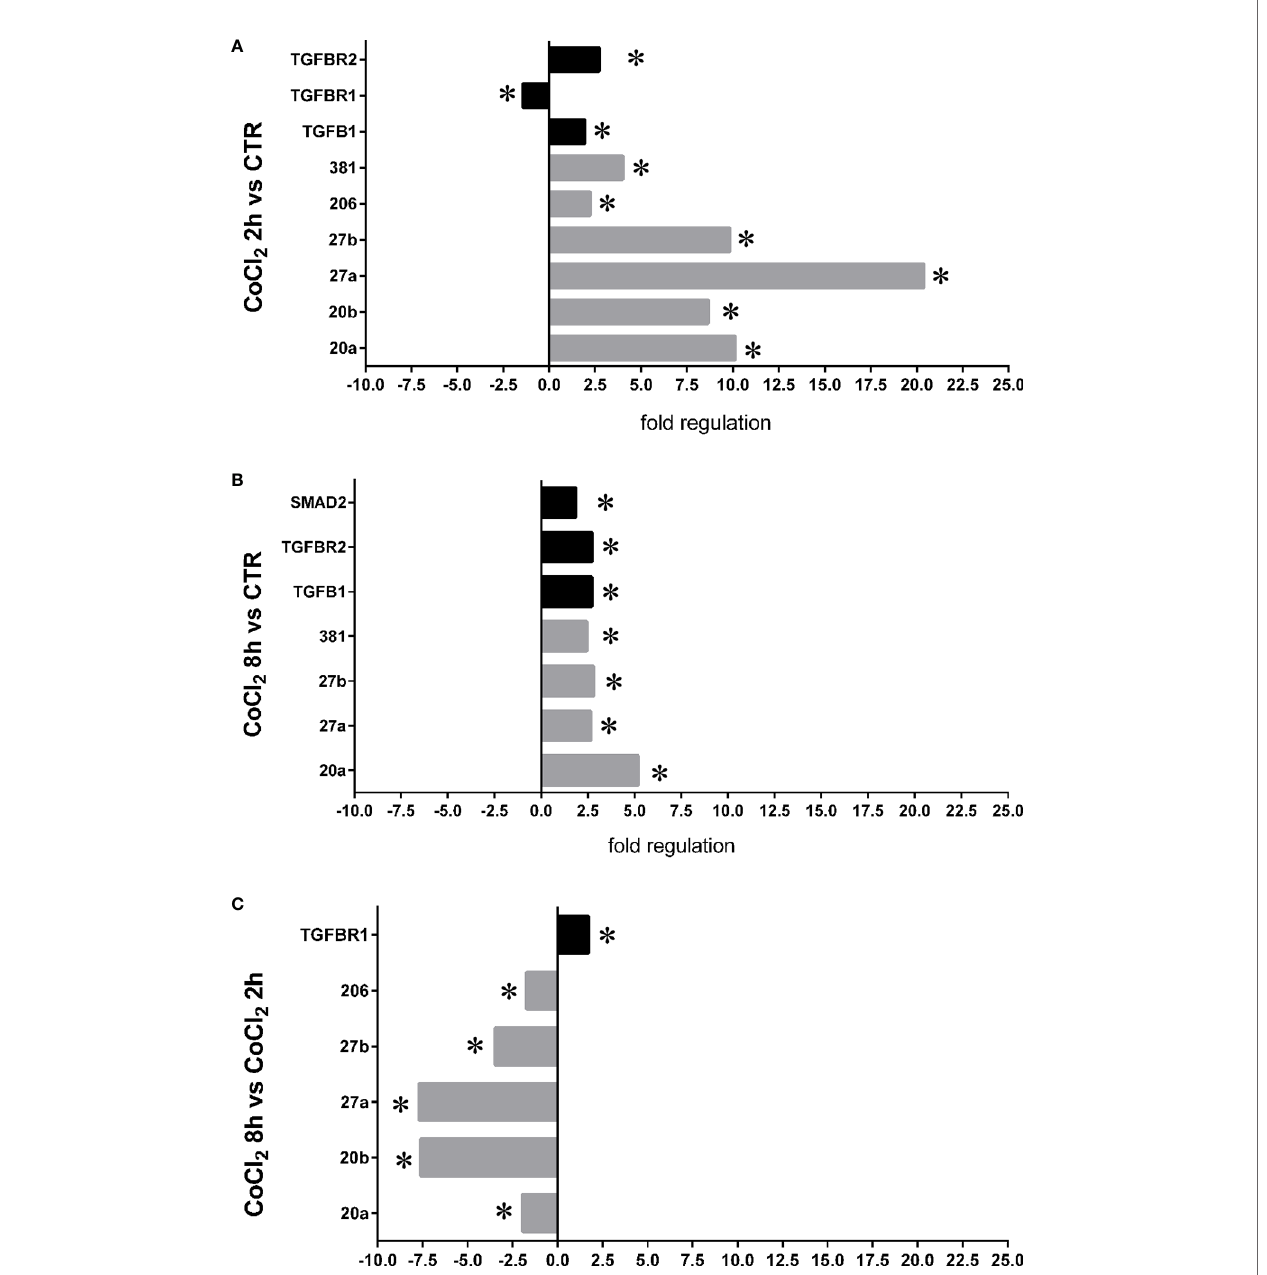
FIGURE 6 | Correlation of microRNAs (miRNAs) and TGF b signaling pathway genes expression in human retinal endothelial cells (HRECs), under chemical hypoxic stimuli. Fold regulation of miRNAs and TGF b signaling genes: (A) *p < 0.05 2 h CoCl2 treatment vs. control (ctr); (B) *p < 0.05 8 h CoCl2 treatment vs. control (ctr); (C) *p < 0.05 8 h vs. 2 h CoCl 2 treatment;